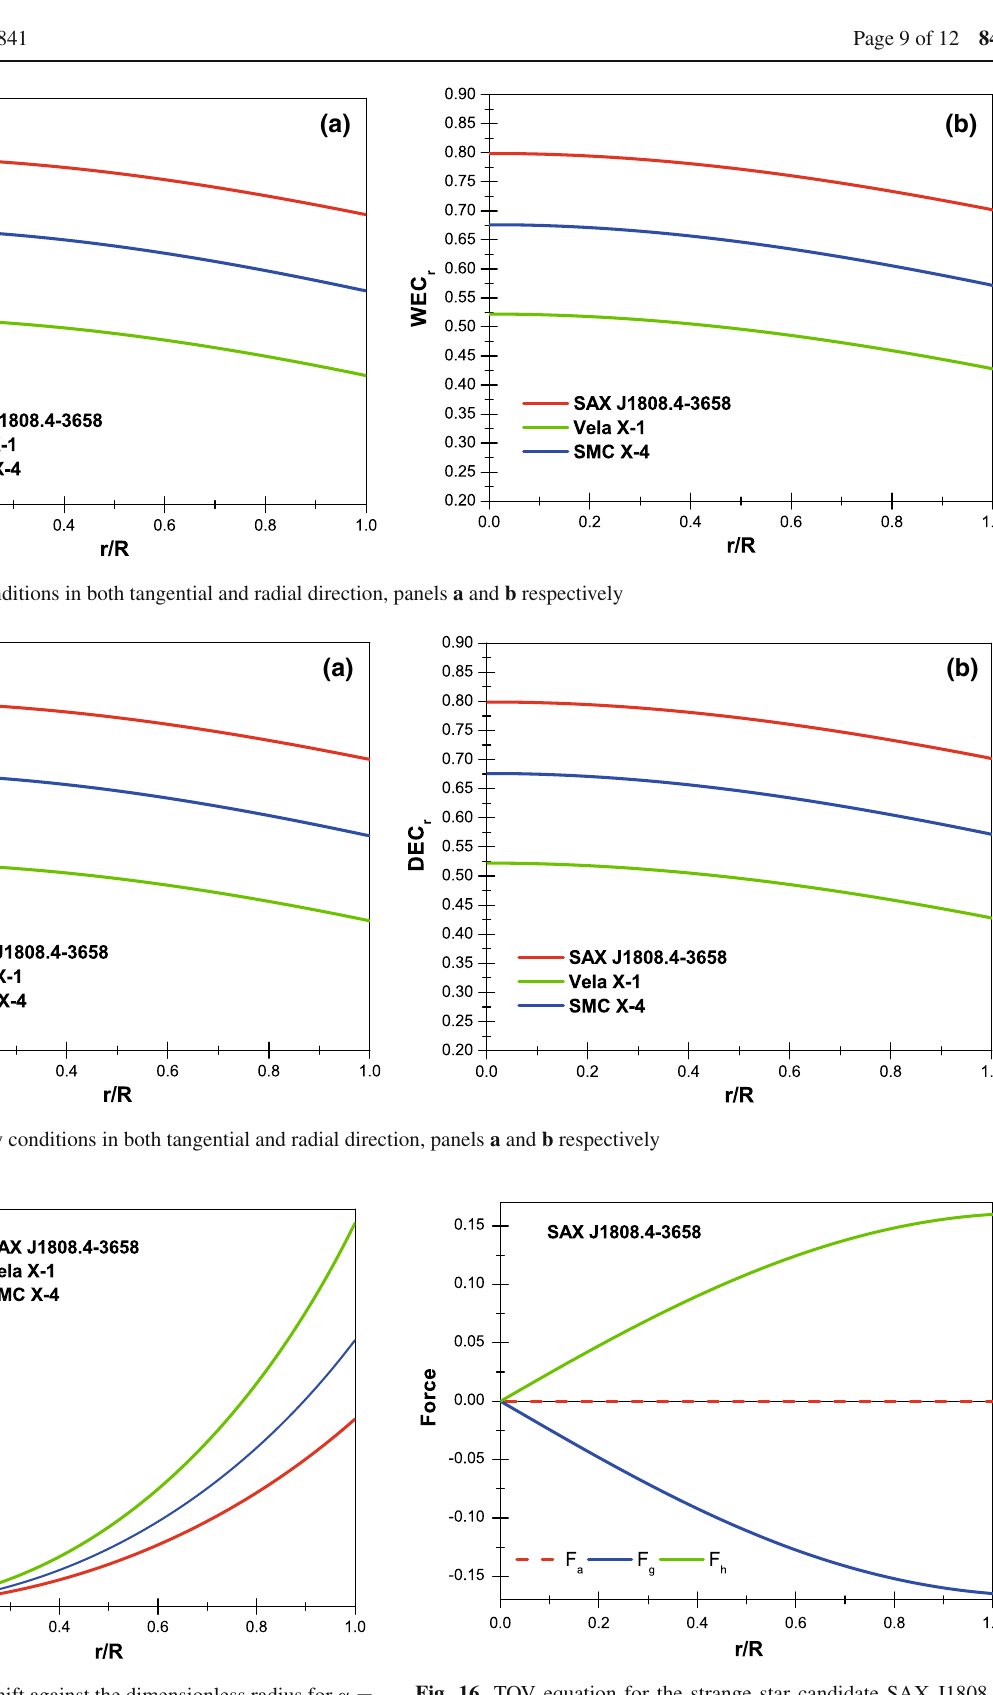
Fig. 15 The surface redshift against the dimensionless radius for α = 0 . 3